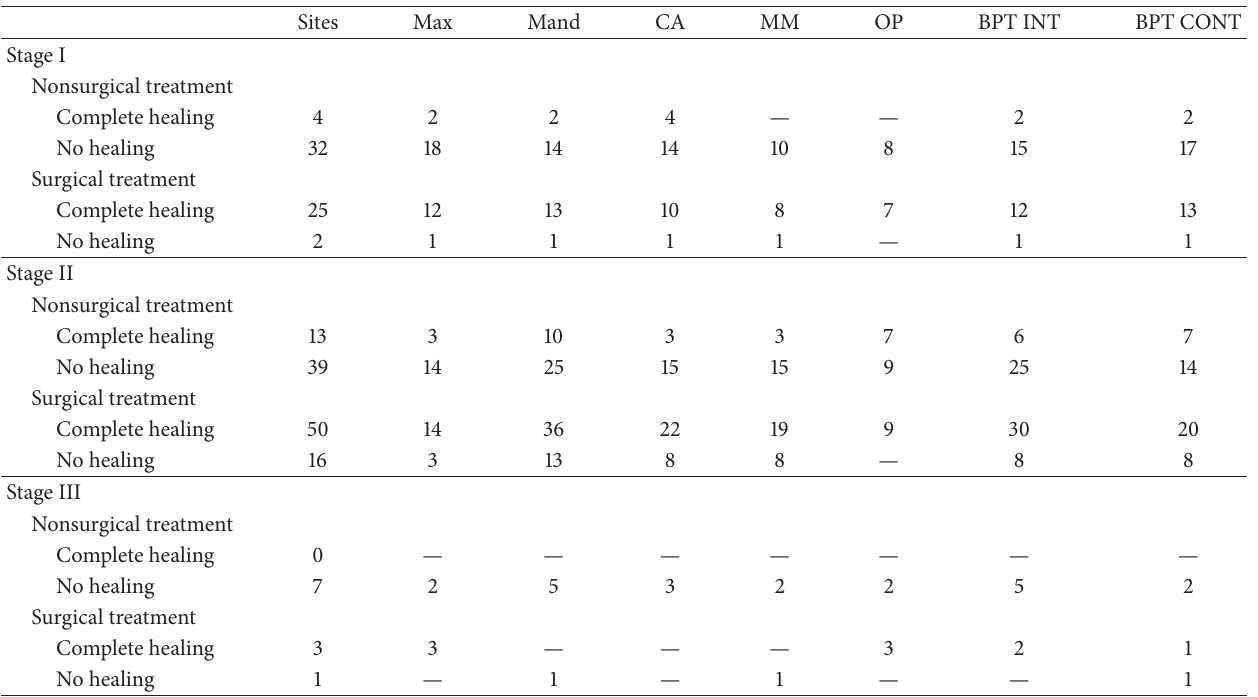
Table 6: Outcome of surgical and nonsurgical